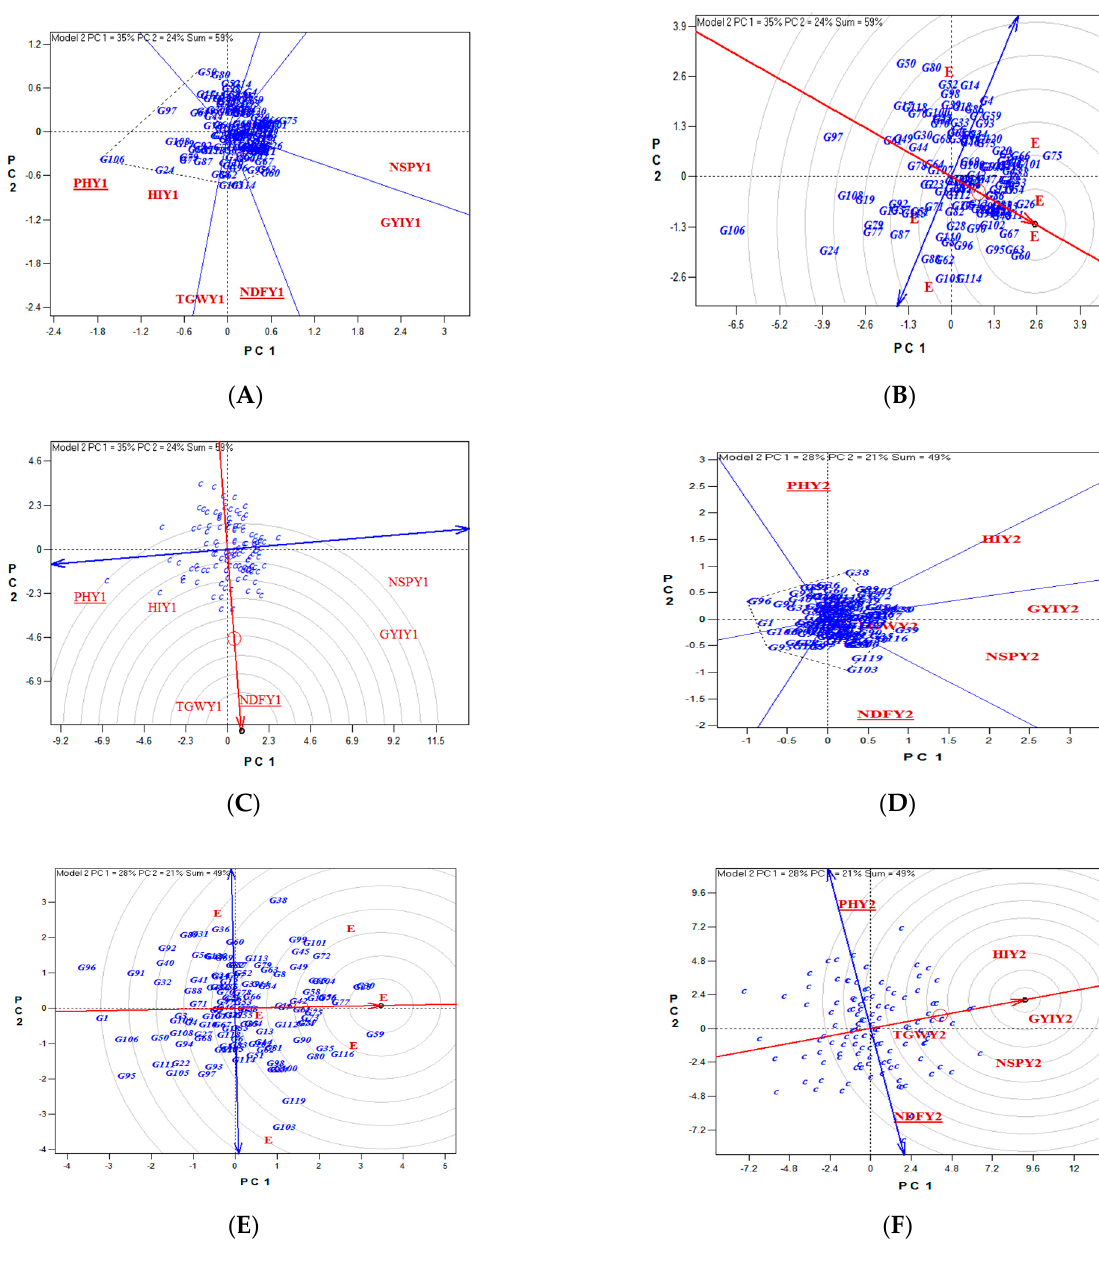
Figure 10. The reaction of lines caused by Gonbad × Kohdasht crosses by considering significant traits in 2020 and 2022 using Biplot. Identifying genotypes with higher values for traits ( A , D ), determining the best genotype considering significant traits ( B , E ), and identifying the most important traits affecting genetic diversity ( C , F ).